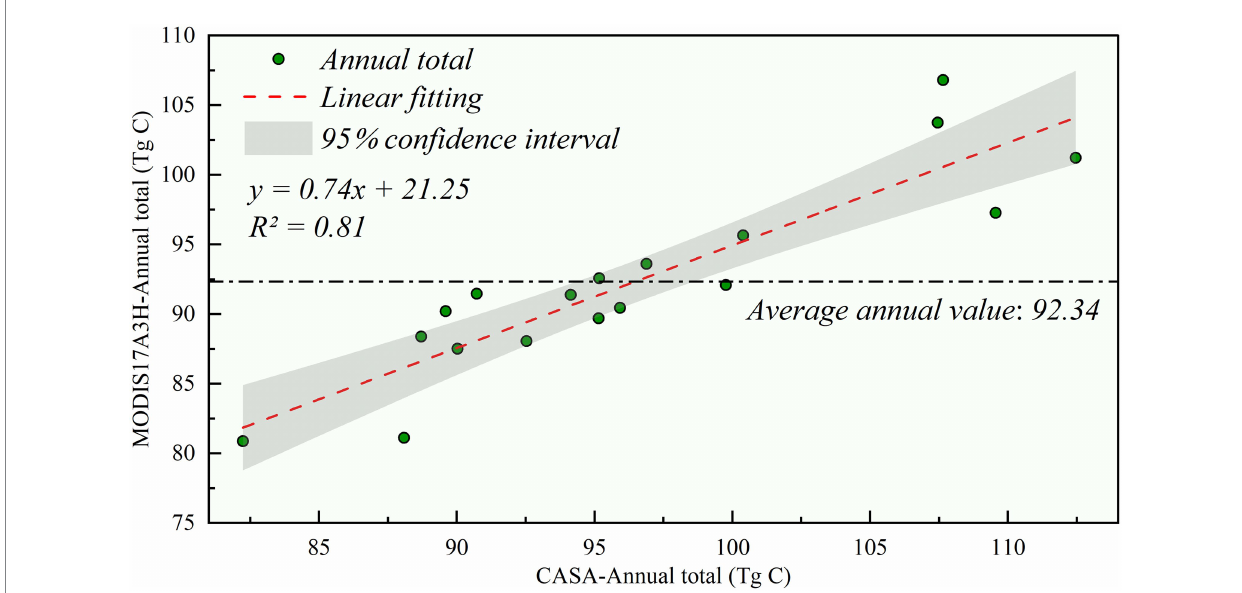
FIGURE 3 Correlation analysis between simulated annual total NPP and total annual MODIS17A3H in China’s NAR,